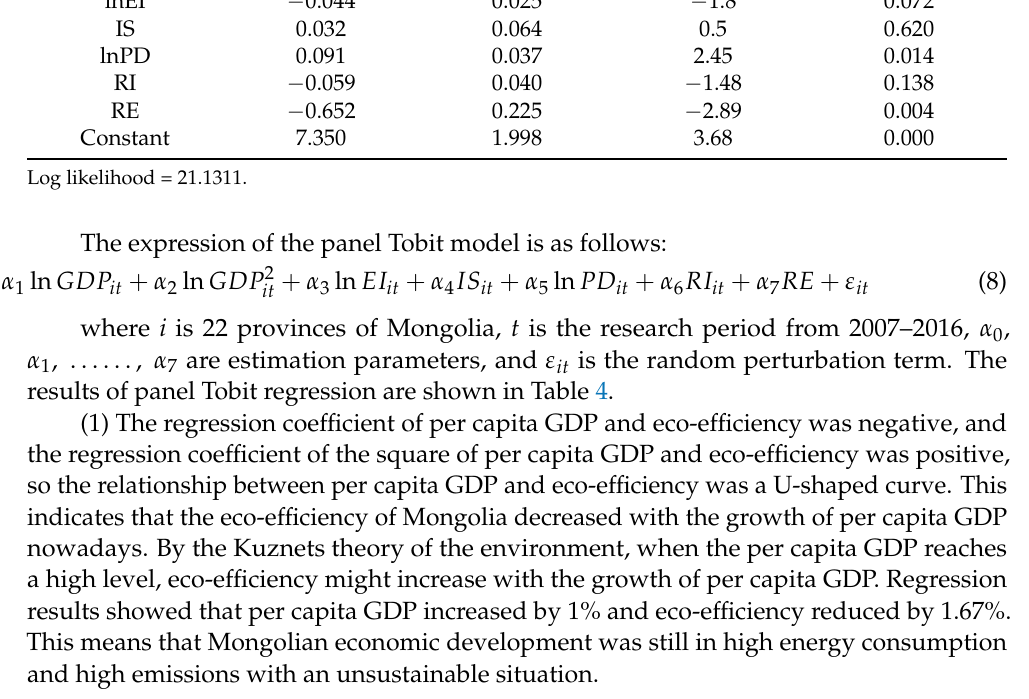
Table 4. Panel Tobit regression analysis of influencing factors of eco-efficiency in Mongolia. Variable Coef.